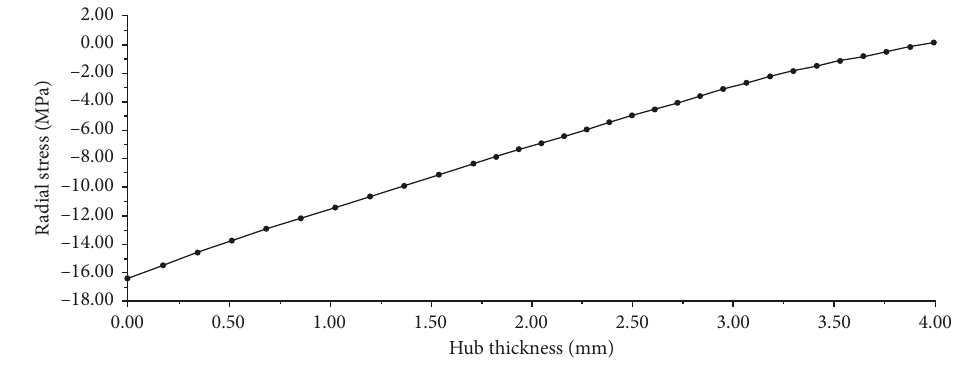
Figure 6: Radial stress of the hub.